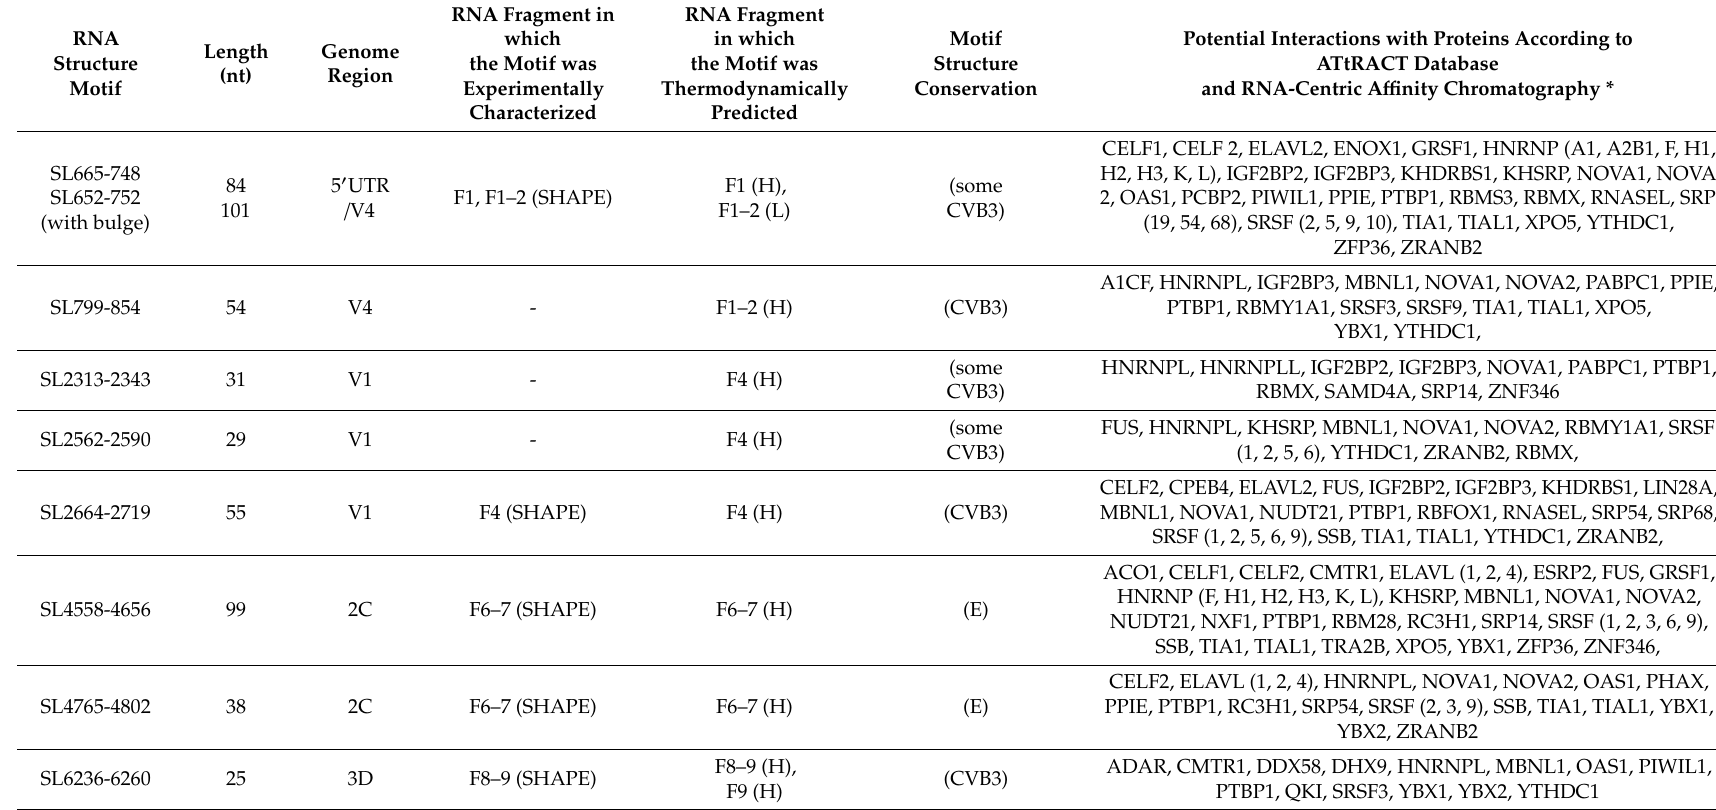
Table 2. Features of the new RNA elements / motifs found in the CVB3 genome. The structure motifs were experimentally characterized with the indicated method / s, (SHAPE) or (SHAPE, Pb 2 + , DMS)—(Figures 2 and 3, and Figure S1); ( − )—experimentally uncharacterized; (H)—structure predicted by RNAstructure with high probability; (L)—structure predicted with low or moderate probability (Figures 2 and 3, and Figure S1); (CVB3)—motif specific for di ff erent CVB3 strains according to RNAalifold; (E)—motif also conserved in other enteroviruses (Figure 4A (CVB3), Figure 4B(E), and Figure S2); potential interactions with proteins were proposed with help of the ATtRACT database [40]; their gene names are indicated in this table (Table S4). * Interactions with proteins and F10 RNA, which were